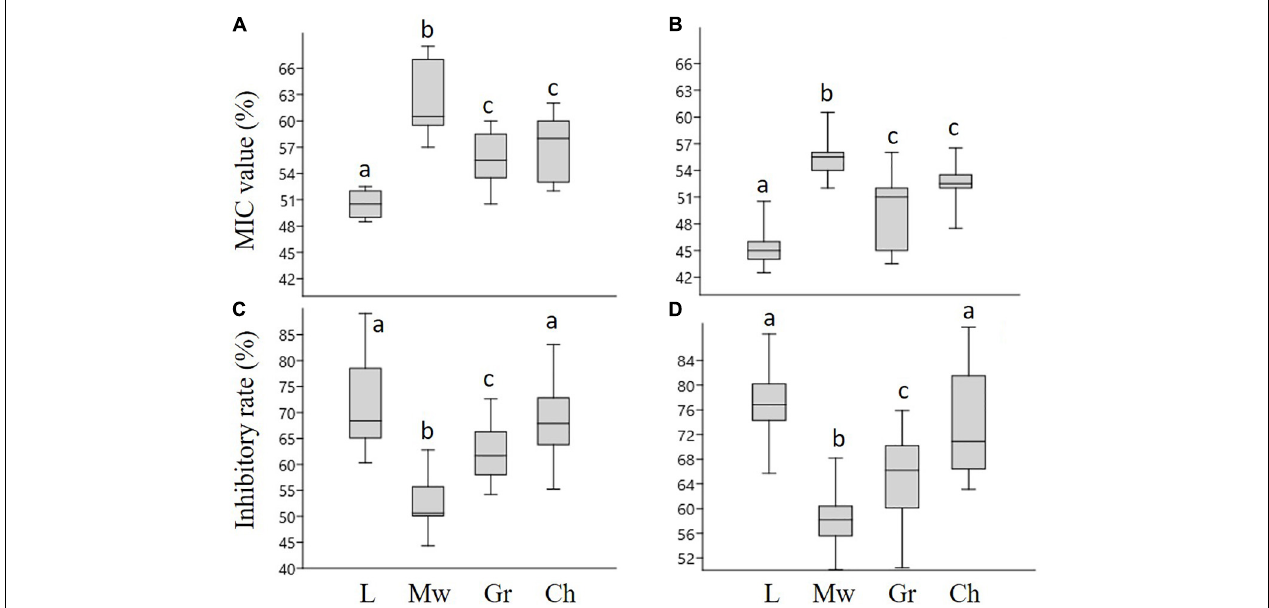
FIGURE 1 | The minimum inhibitory concentration (MIC) values and inhibitory rates of honey samples, against P. aeruginosa (A,C) , and S. aureus (B,D) , respectively. L-linden honey, Mw-milkweed honey, Gr-goldenrod honey, Ch-chestnut honey. Different lower case letters above the boxes indicate significant differences among various honeys according to Student’s t- test ( p < 0.01).